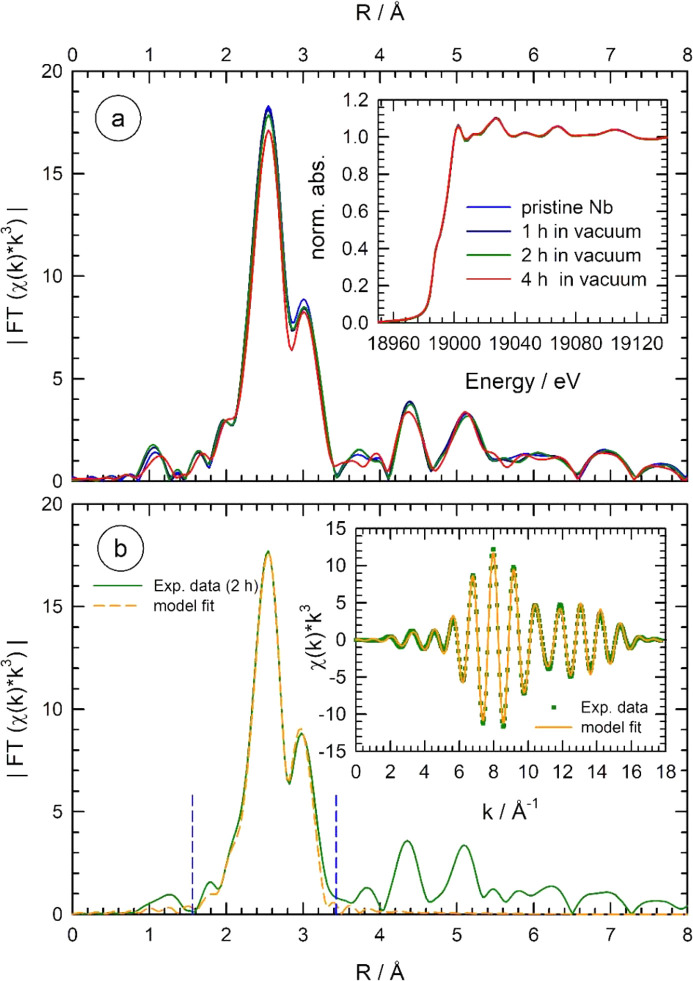
(a) Magnitude of the Fourier transform |FT[χ(k)k
3]| of the k
3-weighted EXAFS fine structures χ(k)k
3 measured for an Nb metal foil (8 µm thickness) at room temperature prior to any heat treatment (blue line) and after a heat-treatment in the new high temperature cell under vacuum conditions close to 10−6 mbar for 1 h (dark blue line), 2 h (green line) and 4 h (red line), respectively (k-range for the FT: 2.2 Å−1 < k < 14.5 Å−1, the shown data are not corrected for phase shifts). Only very small changes are detectable after 4 h of the heat treatment. In the inset, the related near-edge X-ray absorption spectra are compared with negligible changes after the heat treatments. (b) Exemplary fit of the EXAFS data with a two-shell model using the first and second Nb–Nb coordinations of the base-centred-cubic lattice for the sample treated for 2 h under vacuum; the experimental data (green line) as well as the fit (yellow line) are shown. In the inset, the back-transformed k
3-weighted EXAFS fine structures χ(k)k
3 (data from 1.5 Å to 3.4 Å in the FT as indicated by vertical dotted blue lines) are shown for the experimental data (green squares) and the fit (yellow line). See text for more details.